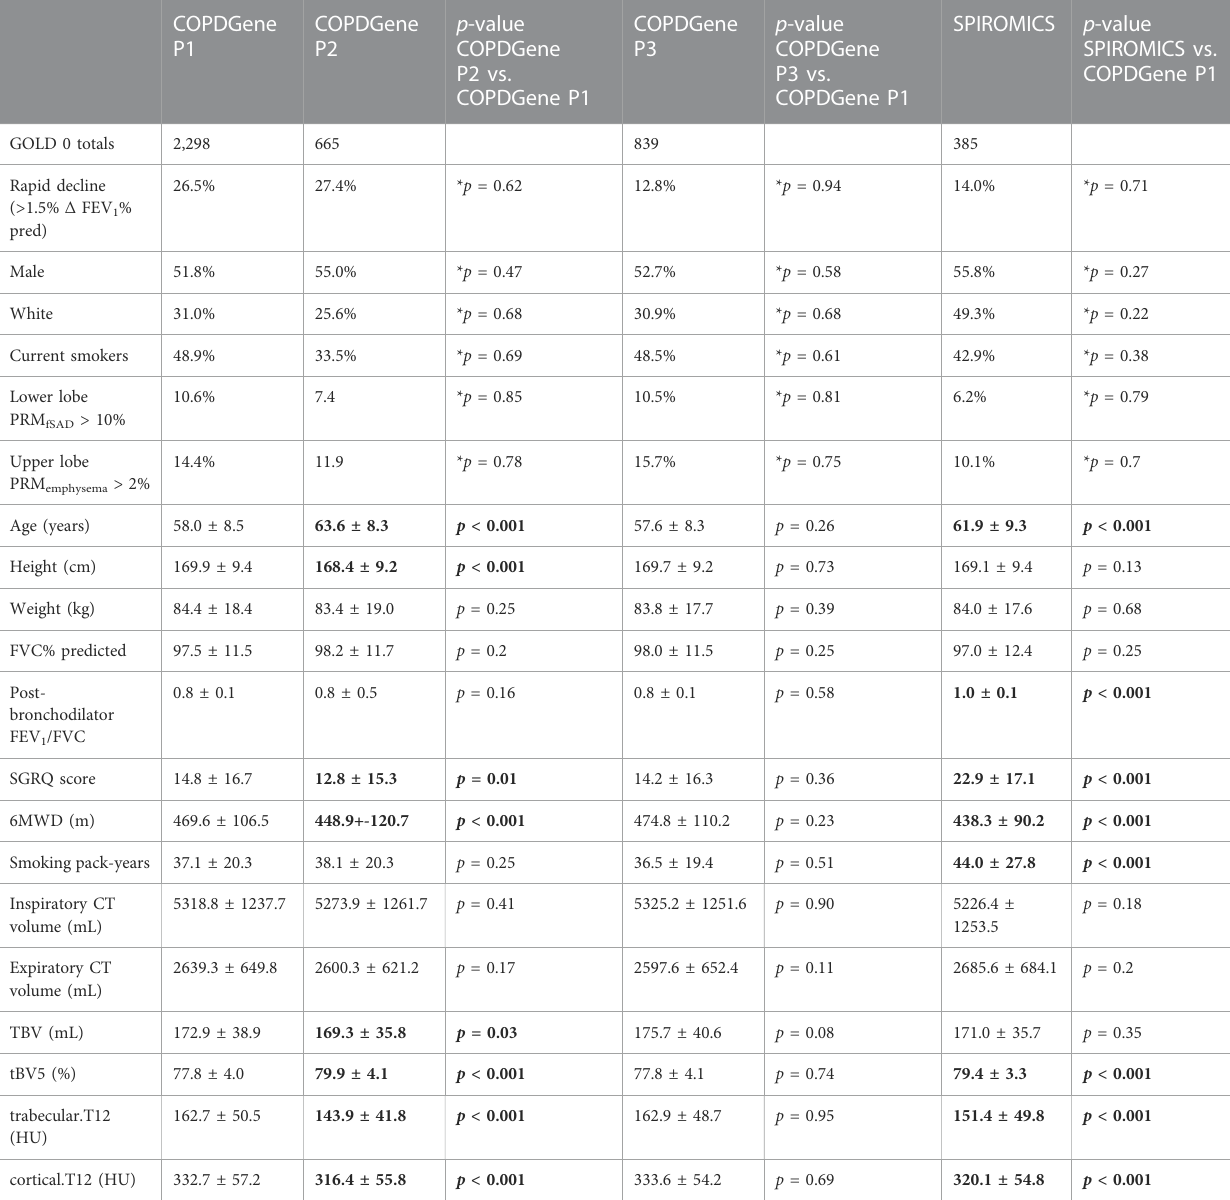
*The z-proportions test was used to compute p -values for binary variables. The unpaired t -test was used to compute p -values for continuous data. Bolded text indicates a p -value < 0.05. Abbreviations:SGRQ,St.George ’ sRespiratoryQuestionnaire;6MWD,6-minwalkdistance;TBV,totalbloodvesselvolume;tBV5,ratioofvasculartreelengthinvesselswithacross-sectional arealessthan5 mm 2 tototalvasculartreevolume;trabecular.T12,averageHouns fi eld unit(HU) valuewithinthetrabecularregionof theT12vertebralbody;cortical.T12,averageHouns fi eld unit (HU) value within the cortical region of the T12 vertebral